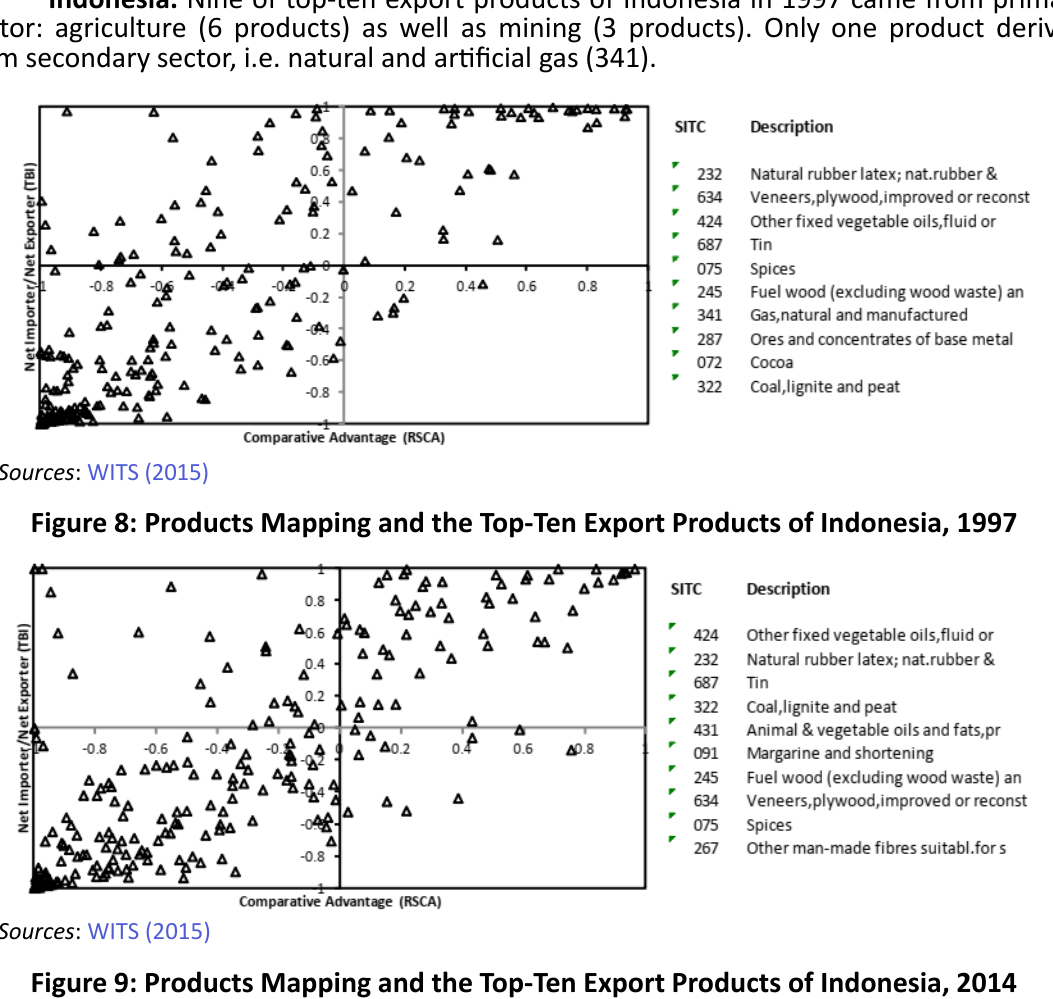
Figure 9: Products Mapping and the Top-Ten Export Products of Indonesia,